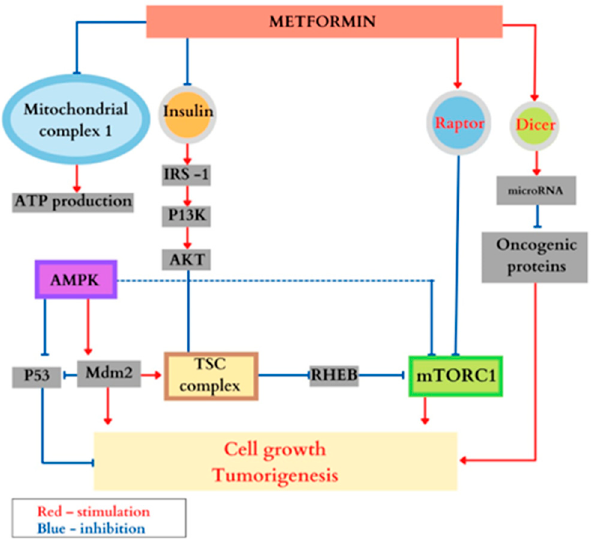
Figure 6. The most important effects of Metformin.